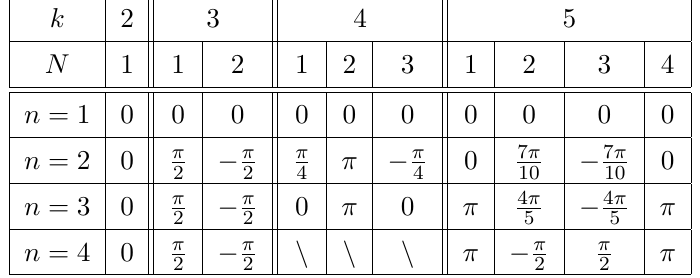
h i Table 5 . The exact values of the phases of Z U ( N ) with b = 1 . Only the values that are k, 0 related to the duality are included here. The value with negative k can be obtained by taking the complex conjugate as in (3.6). This table shows that the duality (4.2) holds. We also numerically h i checked that Z U ( k ) is k, 0